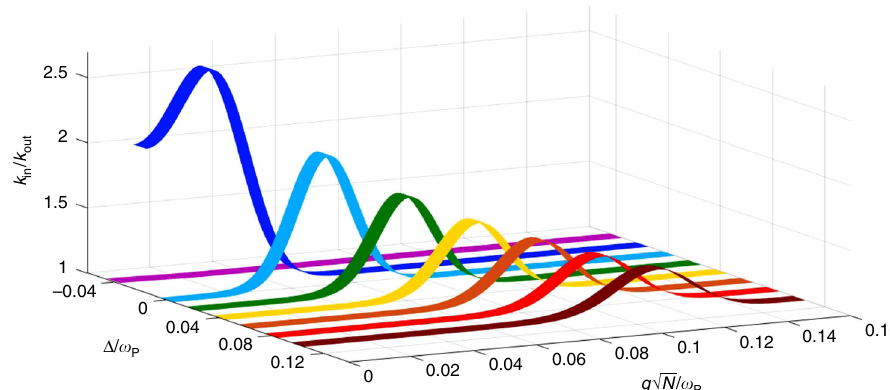
k VSC and k k was calculated at several detunings Δ . For in ¼ out ¼ R ! P R ! P , and E z 4 : 9 _ ω . In agreement with Marcus theory, as the lower 001 ¼ P P